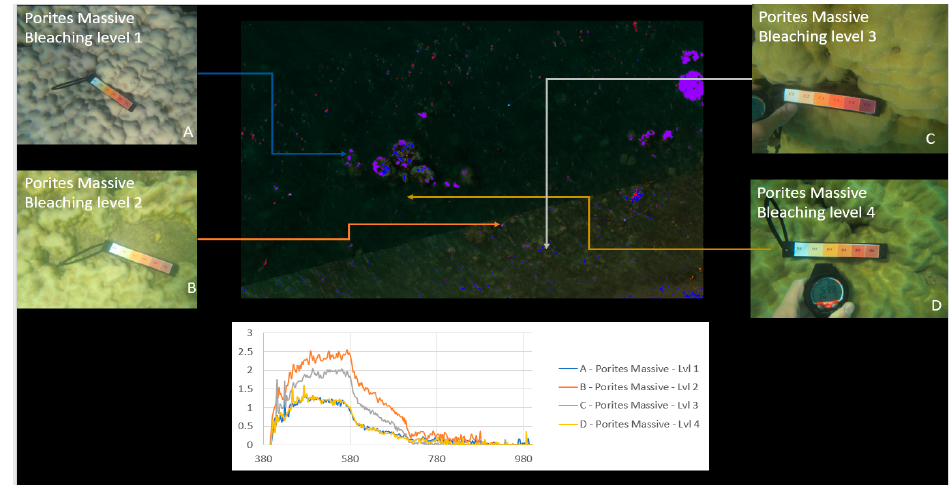
Figure 19. Porites massive material classification, with water classification omitted.